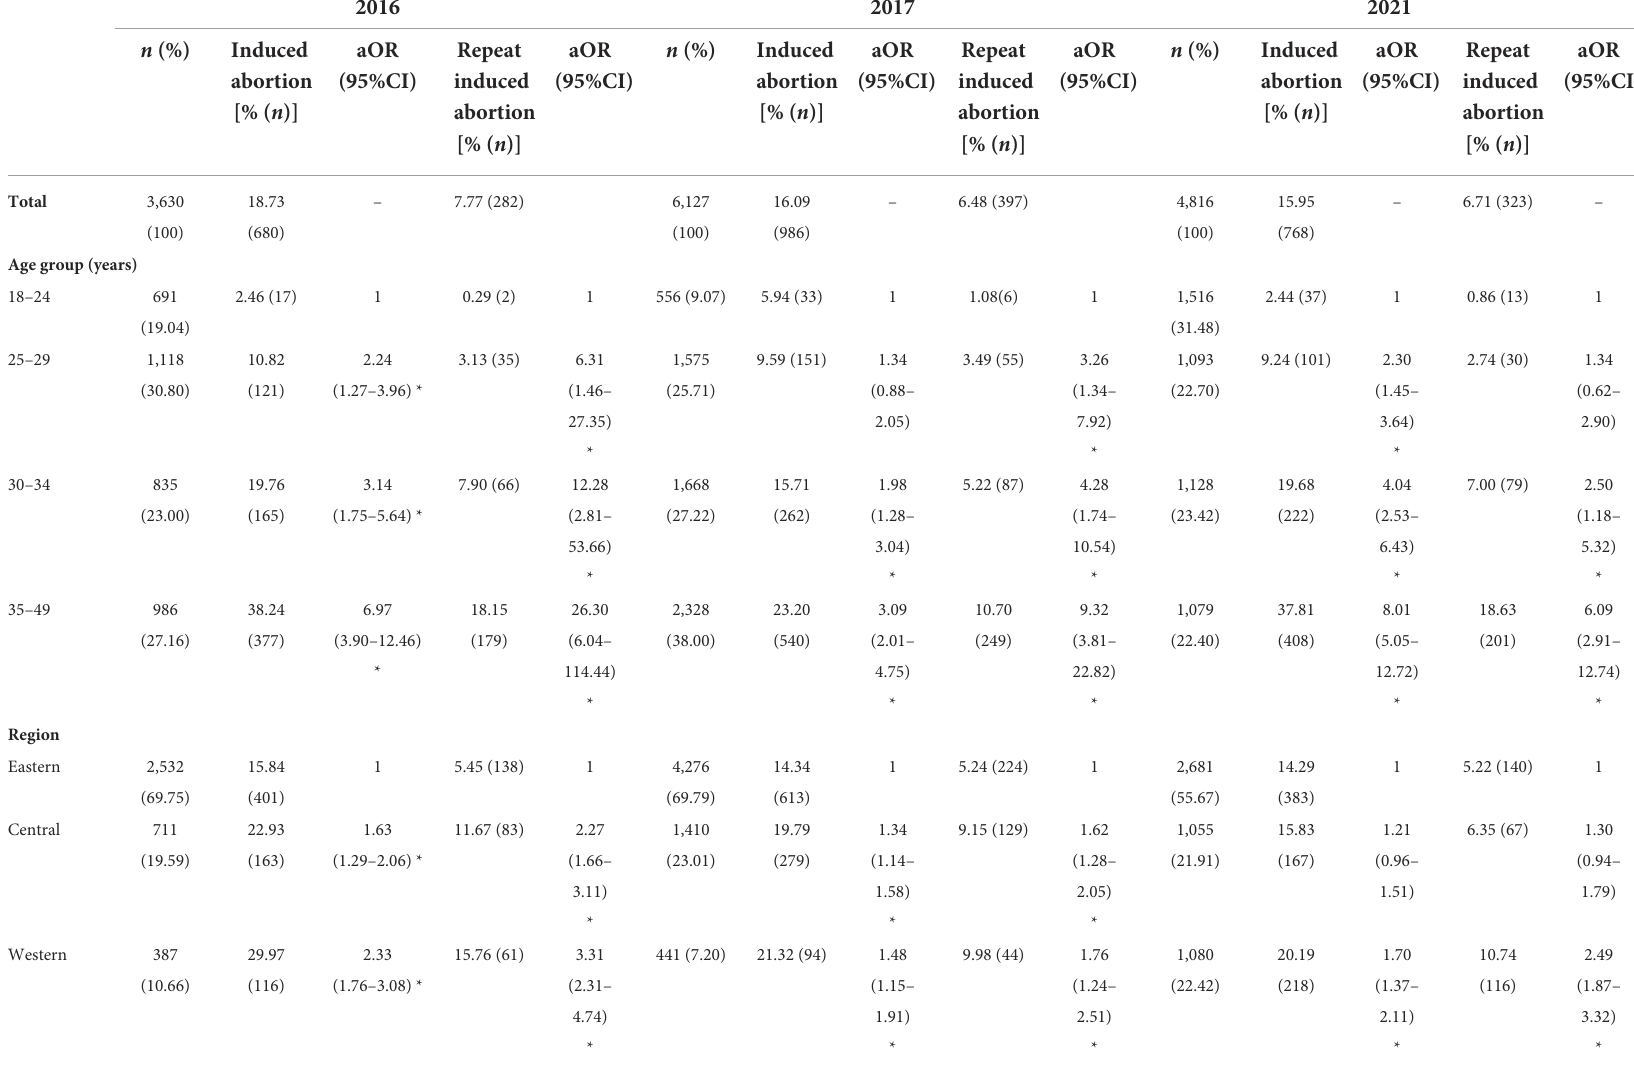
TABLE 2 Factors related to induced abortion and repeated induced abortion in the multivariate model stratified by survey